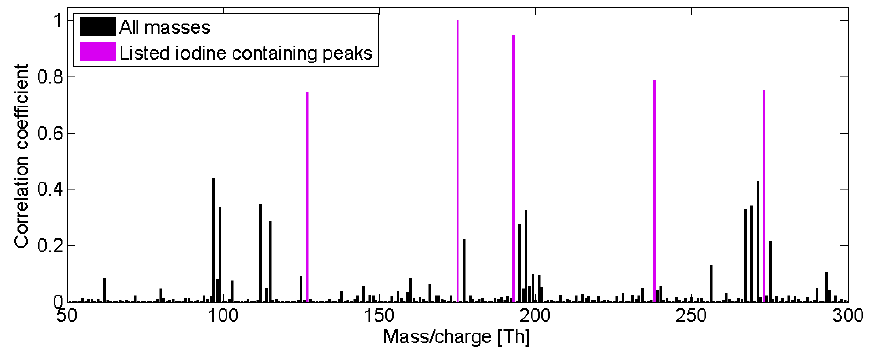
Fig. 11. Correlogram of integer m/Q 175Th to peaks in the m/Q range 50–300Th. Correlation coefficients ( R 2 ) calculated for 7 days of ambient measurements. The highlighted iodine peaks refer to the iodine containing peaks in Fig. 10.